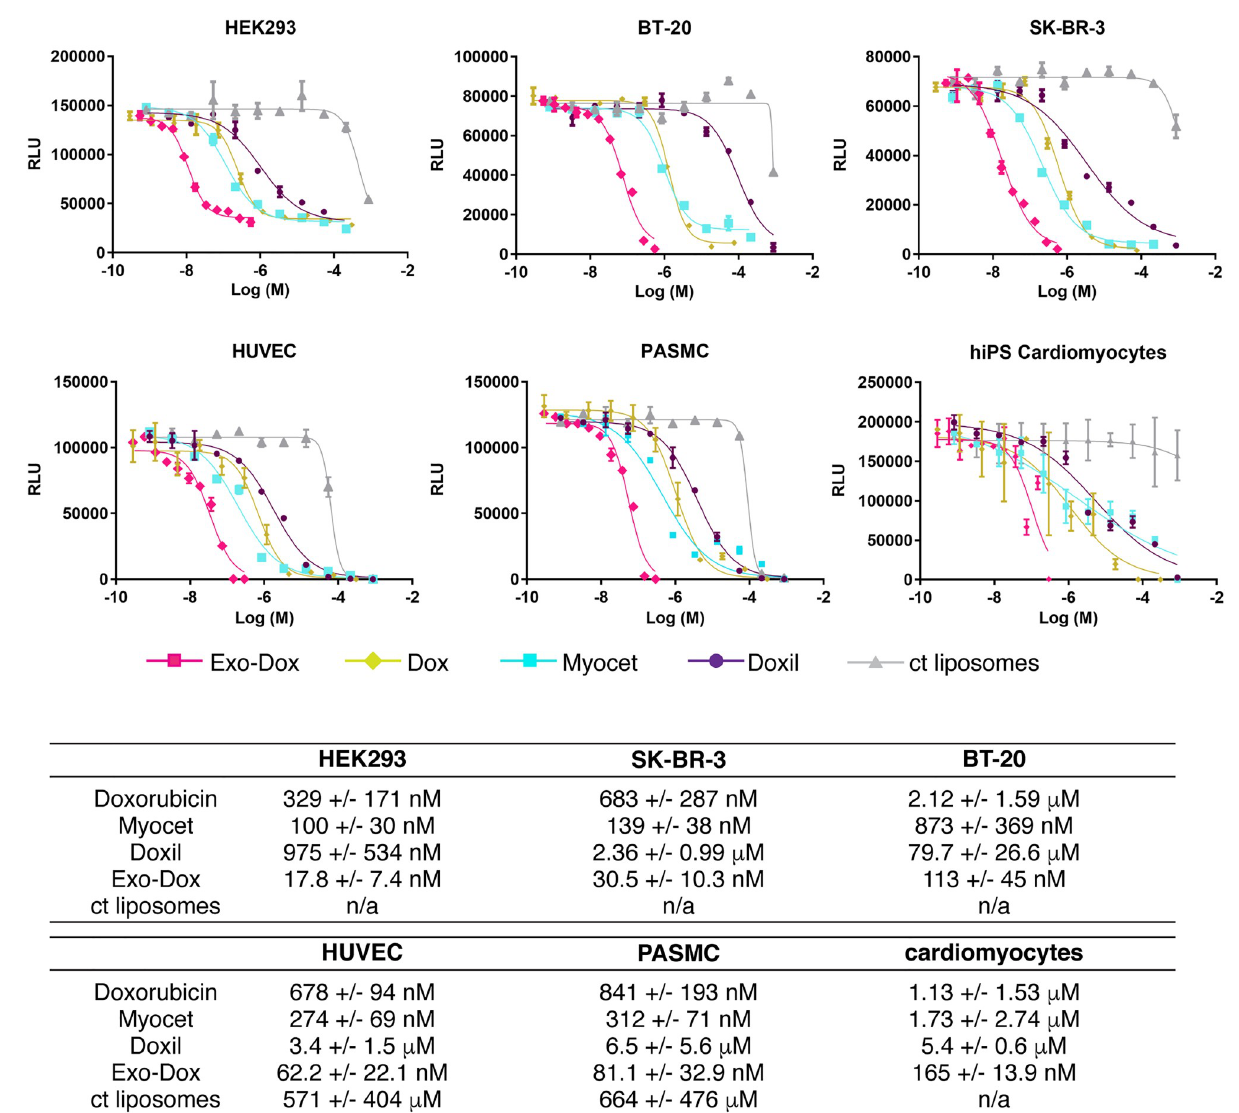
Fig 5. Exosomal doxorubicin is more potent than free doxorubicin or liposomal formulations of doxorubicin in a wide range of cultured cells. HEK293, SK-BR-3, BT-20, HUVEC, PASMC and hiPS cardiomyocytes were treated with increasing amounts of Dox, Exo-Dox, Myocet, Doxil or control liposomes in duplicate for 48 h (HEK293, SK-BR-3, BT20) or 72 h (HUVEC, PASMC, iCell cardiomyocytes). Cellular ATP content as measure of cell viability was determined using luminescent cell titre Glo assay. Results were plotted in GraphPad Prism 6 using a 4-parameter logistic equation to give IC50 values. Representative graphs are shown in (a). (b) table summarising mean +/- SEM. IC50 values from n = 3 independent experiments performed in HEK293, SK-BR-3, BT-20, HUVEC and PASMC and n = 2 independent experiments performed in hiPS cardiomyocytes.